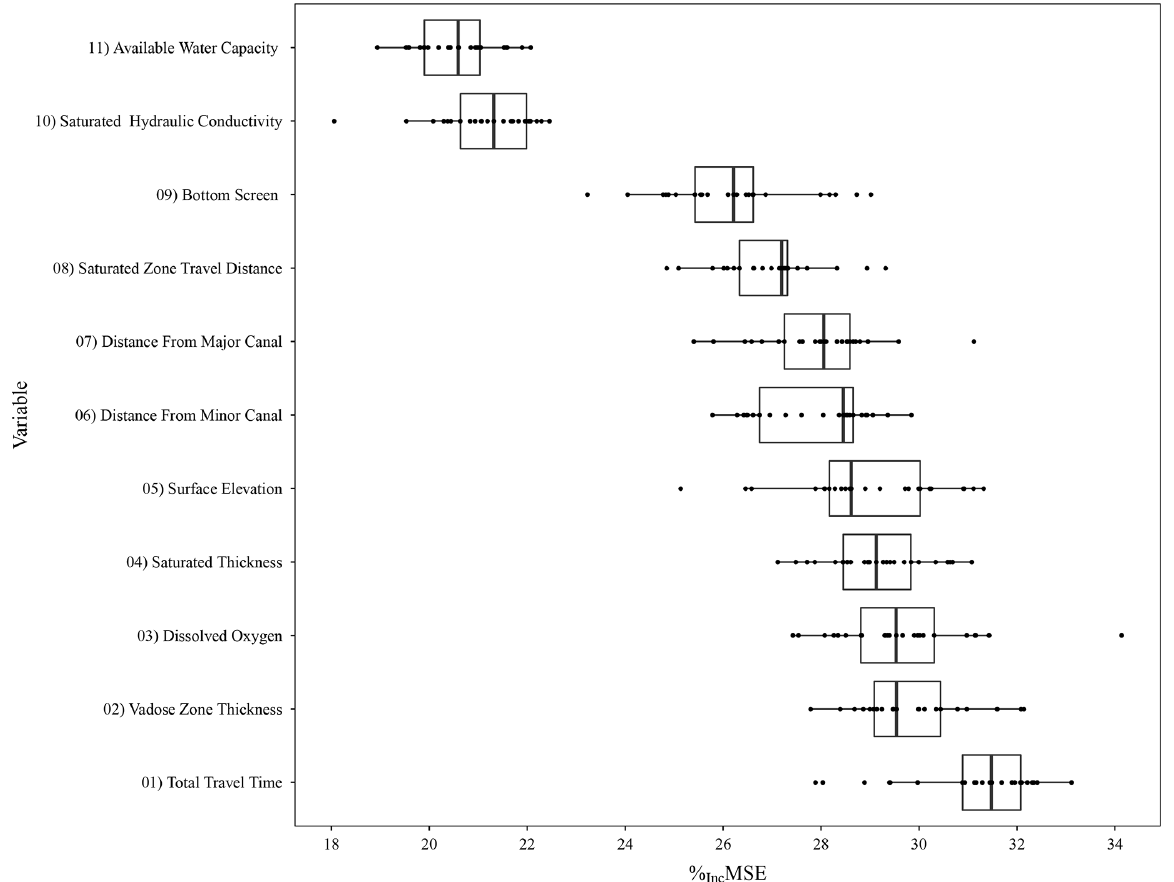
Figure 7. Plot from the secondary analysis exploring the variable importance of the transport rate combination with the largest median % inc MSE in total travel time ( V u = 3 . 5myr − 1 ; V s = 3 . 75myr − 1 ). Each point is from one of 25 random forest models that were run for this evaluation. A larger % inc MSE suggests the variable had a greater influence on a model’s ability to predict NO − s